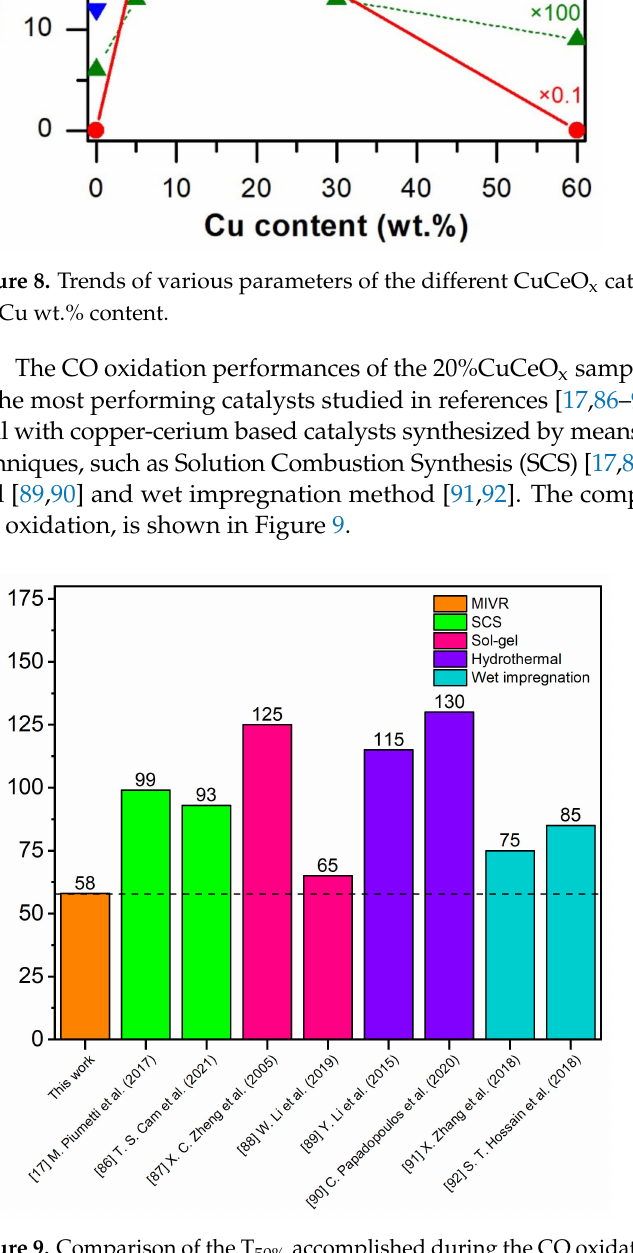
Figure 9. Comparison of the T 50% accomplished during the CO oxidation among the most performing copper-cerium based catalysts synthesized by different techniques reported in the literature and the 20%CuCeO x sample studied in this